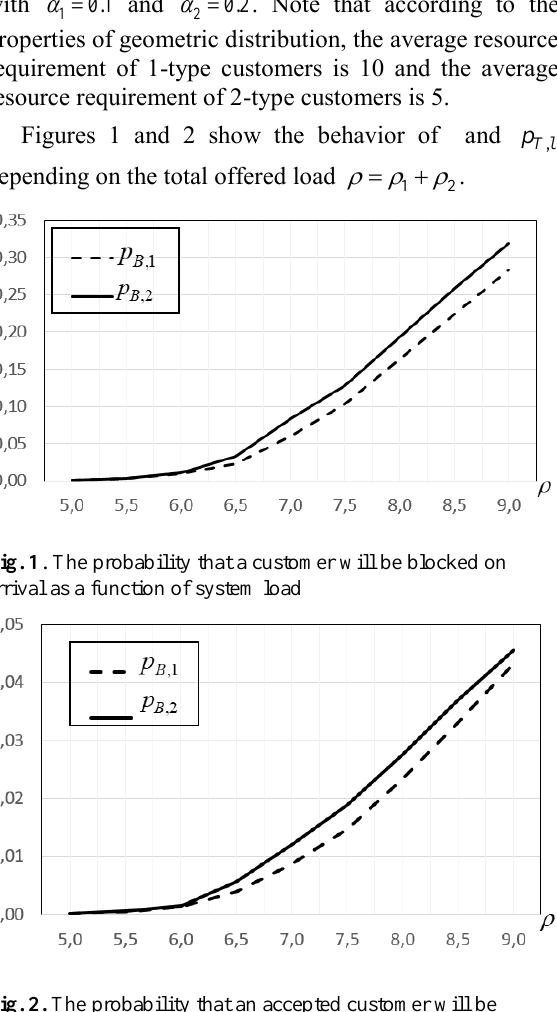
Fig. 2. The probability that an accepted customer will be blocked on signal arrival as a function of system load